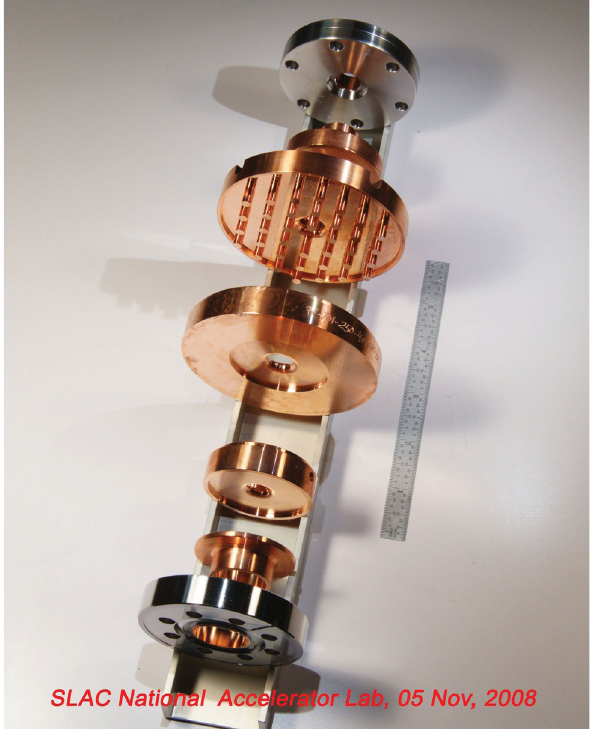
FIG. 10. PBG structure copper parts prior to brazing. A 152.4 mm ruler is located next to the structure to indicate the